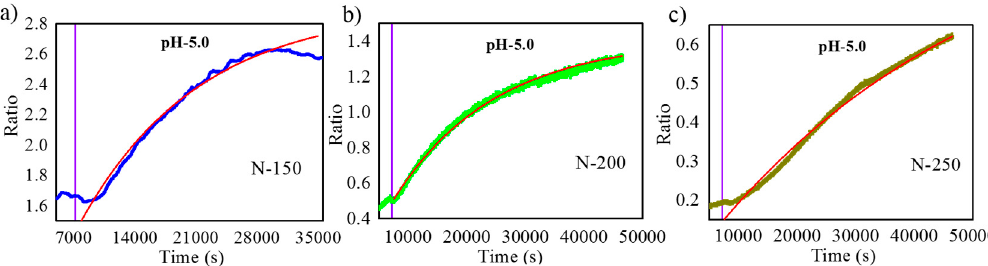
Figure 10. Ratio of the maximum intensity of the signal band to the maximum intensity of the reference band as a function of time, for samples with ( a ) N = 150, ( b ) N = 200, ( c ) N = 250. The line in each graph is the best fit for an exponential function as described in the text.